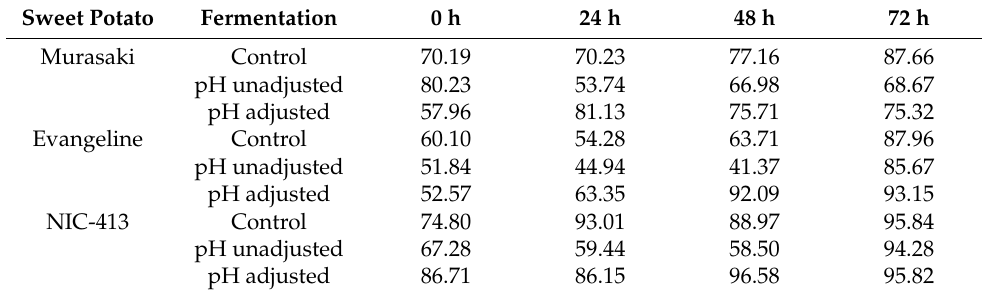
Table 5. Angiotensin-I-converting enzyme (ACE) inhibitory (%) activity (undiluted) of unfermented and fermented (pH adjusted and unadjusted) sweet potato samples ( n = 12) at 0, 24, 48, and 72 h fermentation time